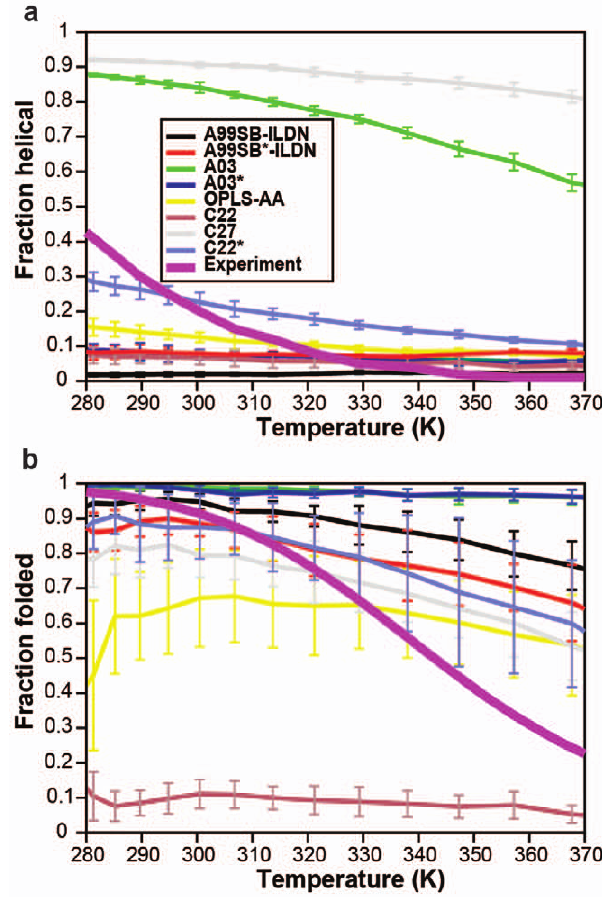
Figure 2. Comparison between calculated and experimental secondary structure propensities. In (a), we show the helical fraction of the (AAQAA) 3 15-mer peptide in simulations and experiment as a function of temperature. In (b), we show the fraction folded of the CLN025 10-residue peptide in simulations and experiments as a function of temperature.